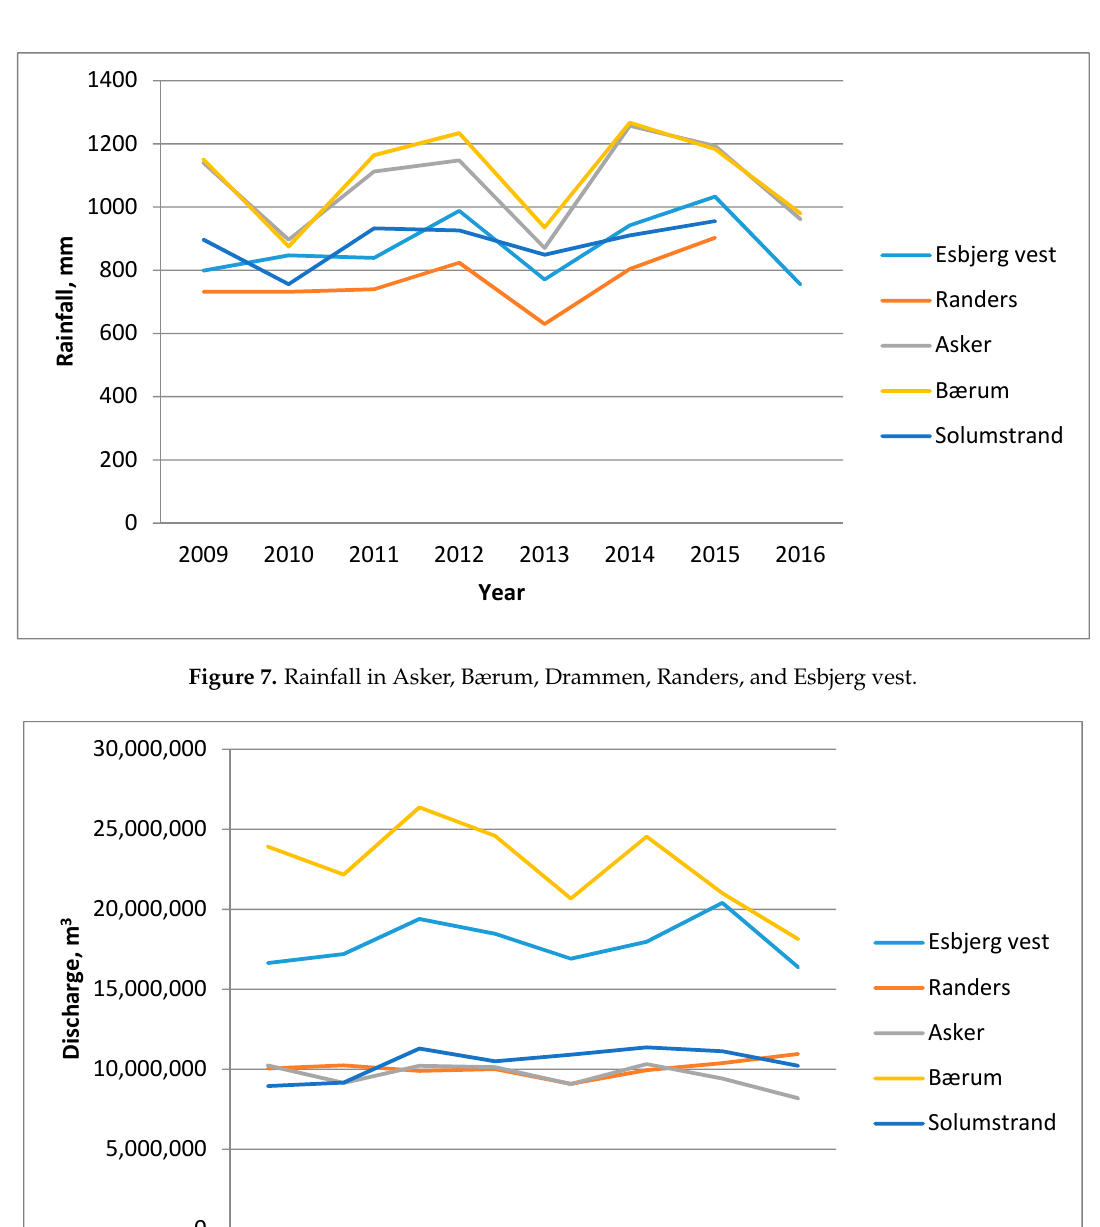
Table 12. Results from a linear regression analysis between rainfall and discharge for Asker, Bærum, Drammen, Randers, and Esbjerg vest.